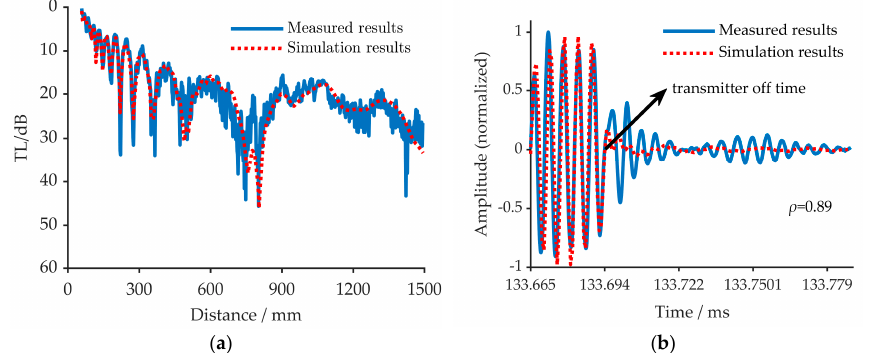
Figure 16. The verification approaches, ( a ) solid blue line means the TL measured in experiment and the dashed red line represents the TL simulated by inversion result; ( b ) solid blue line means the normalized signal amplitude in the time domain at the 470th reception point (one meter from the starting point), and the dashed red line represents the normalized signal amplitude in the time domain simulated by inversion result. The after off effects of the transmitter are highlighted by arrows.